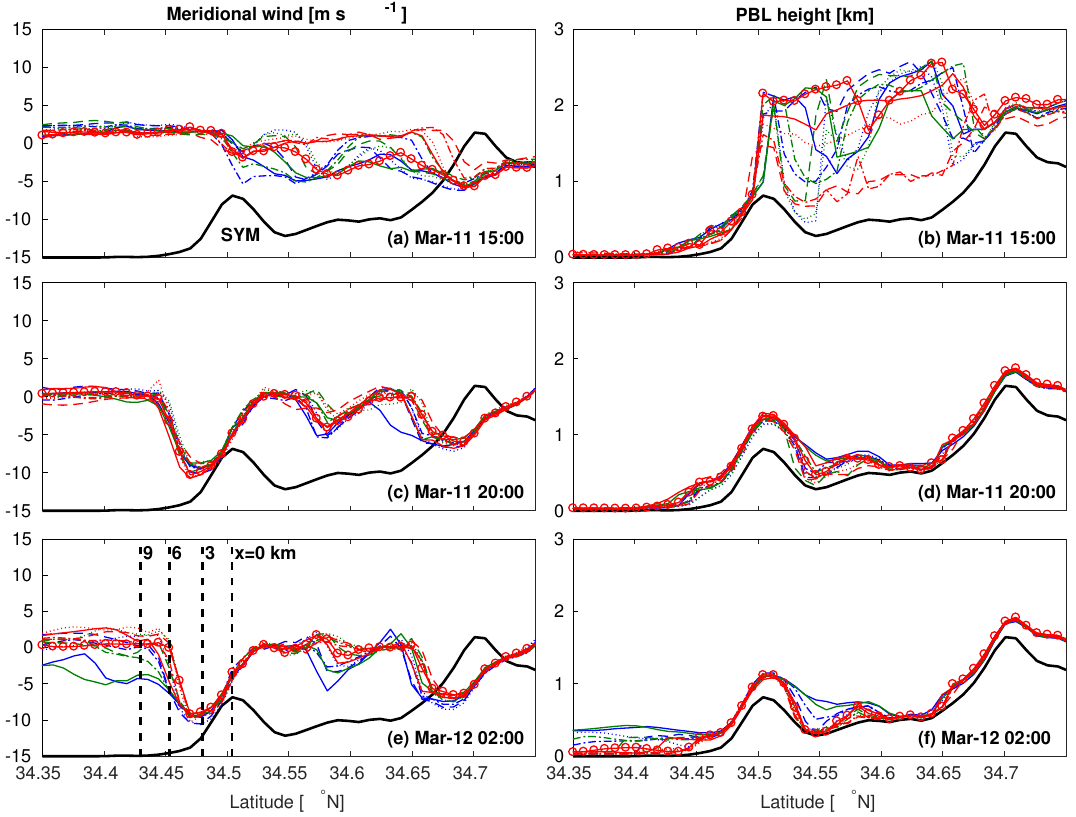
Figure 7. ( a , c , e ) Horizontal cross sections of meridional wind component at 10 m agl and ( b , d , f ) vertical cross sections of the PBL height for all configurations (see Figure 6 for the legend) at the indicated times (PST) for the 11–12 March case. The four vertical dashed lines in ( e ) are used in Figure 8, where the left dashed line indicates the airport